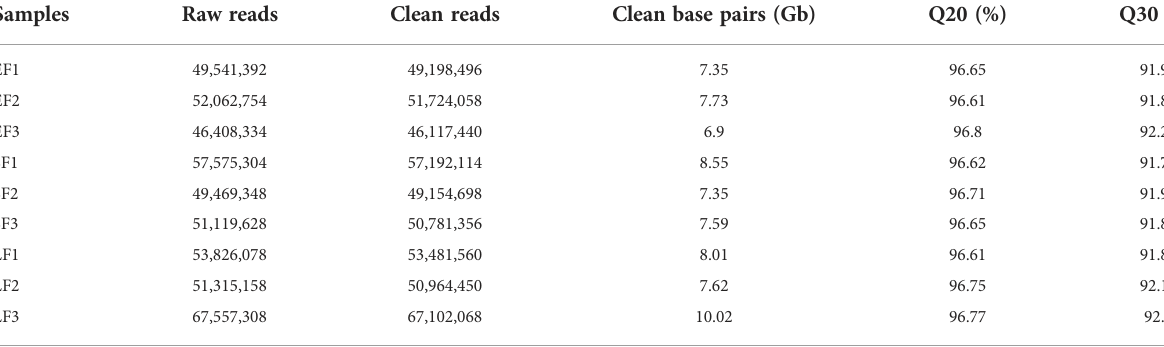
TABLE 1 Statistics of transcriptome data of Rosa hybrida ‘ Tianmidemeng ’ .